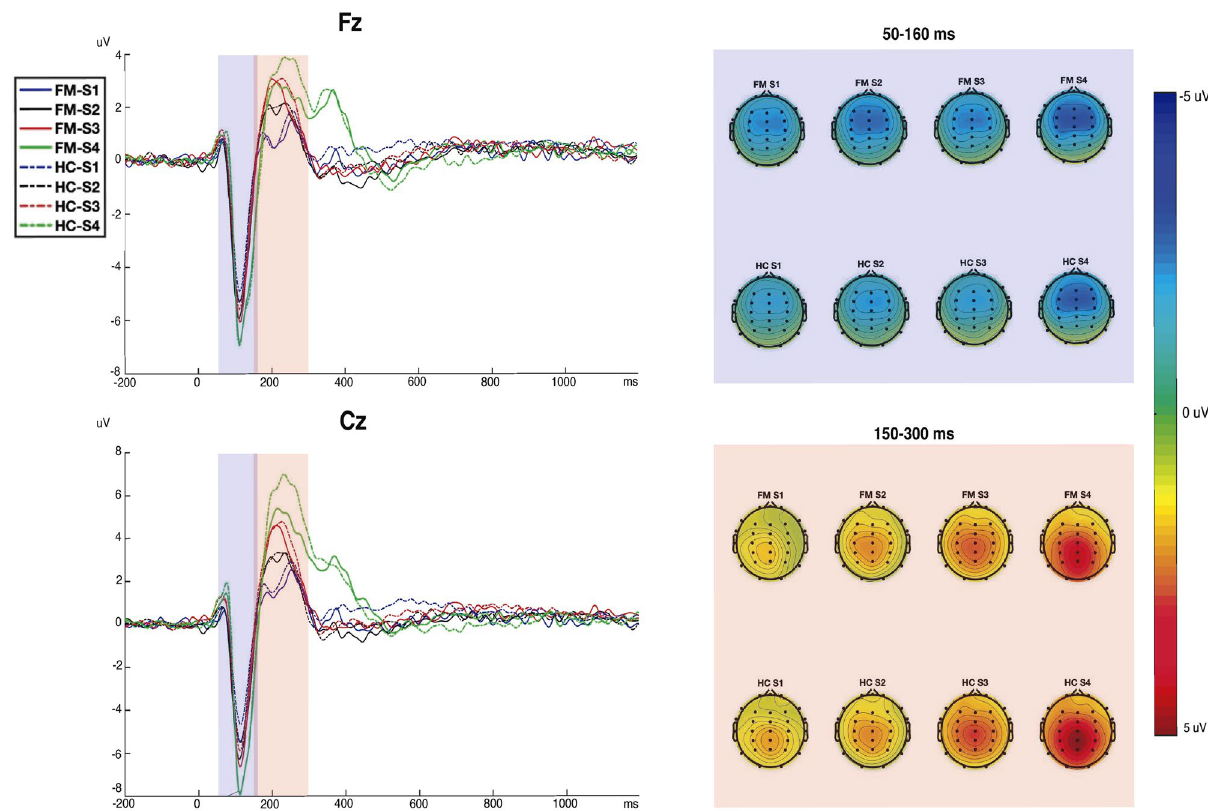
Figure 1. Right. Electrical brain activity in response to auditory stimulation in patients with fibromyalgia (FM) and healthy controls (HC). The waveforms represent the auditory evoked potentials (AEPs) at electrodes Fz (up) and Cz (bottom) elicited by the tones of 70 dB (S1; blue line), 80 dB (S2; black line), 90 dB (S3; red line) and, 105 dB (S4; green line). Left. Spatial distribution of the electrical activity elicited by stimuli of different intensities. The upper part shows the topographic representation of N1 (measured as the mean value from 50 to 160 ms after the presentation of the stimuli), and the lower part shows the topography of P2 (measured from 150 to 300 ms).